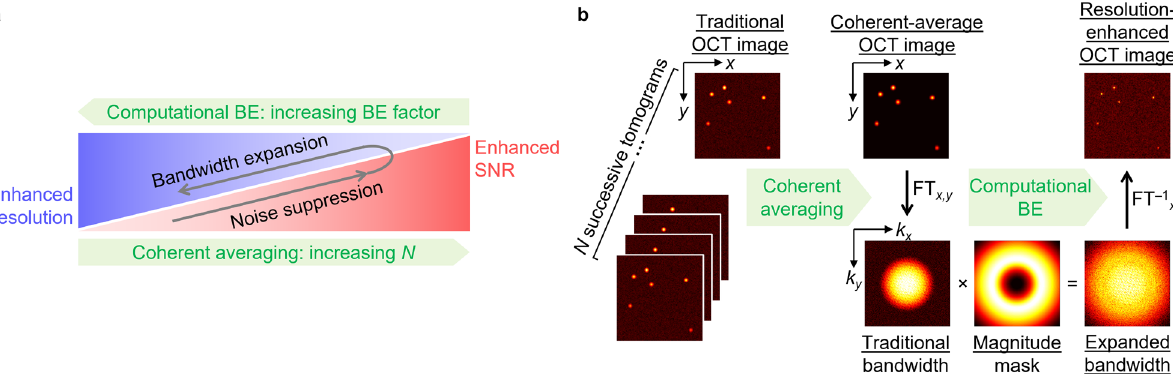
Figure 1. Underlying principle of RE-OCT. ( a ) Information exchange between resolution and SNR facilitated by noise suppression and spatial-frequency bandwidth expansion. RE-OCT utilizes coherent averaging to efficiently suppress noise and enhance SNR, then SNR is sacrificed in the computational BE procedure to enhance resolution. ( b ) Illustration of RE-OCT process to implement the principle in ( a ). Supplementary Section IV provides a full description of RE-OCT reconstruction procedure. BE bandwidth expansion, FT Fourier